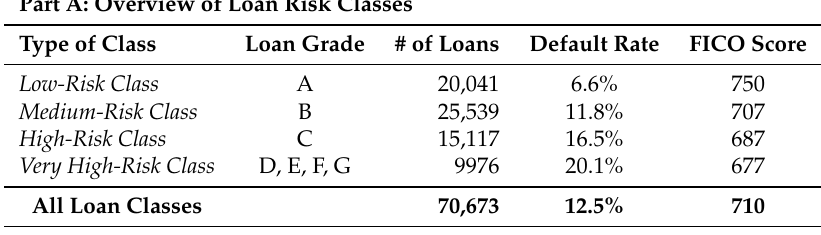
Table 3. Loan Risk